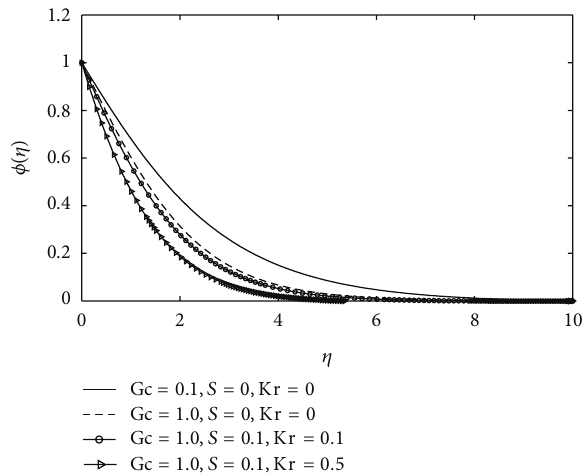
Figure 16: Concentration profiles for different values of Gc, 𝑆 , and Kr for Ha = 0.1 , Gr = 0.1 , Sc = 0.62 , Bi = 0.1 , Nc = 0.01 , and Pr = 0.72